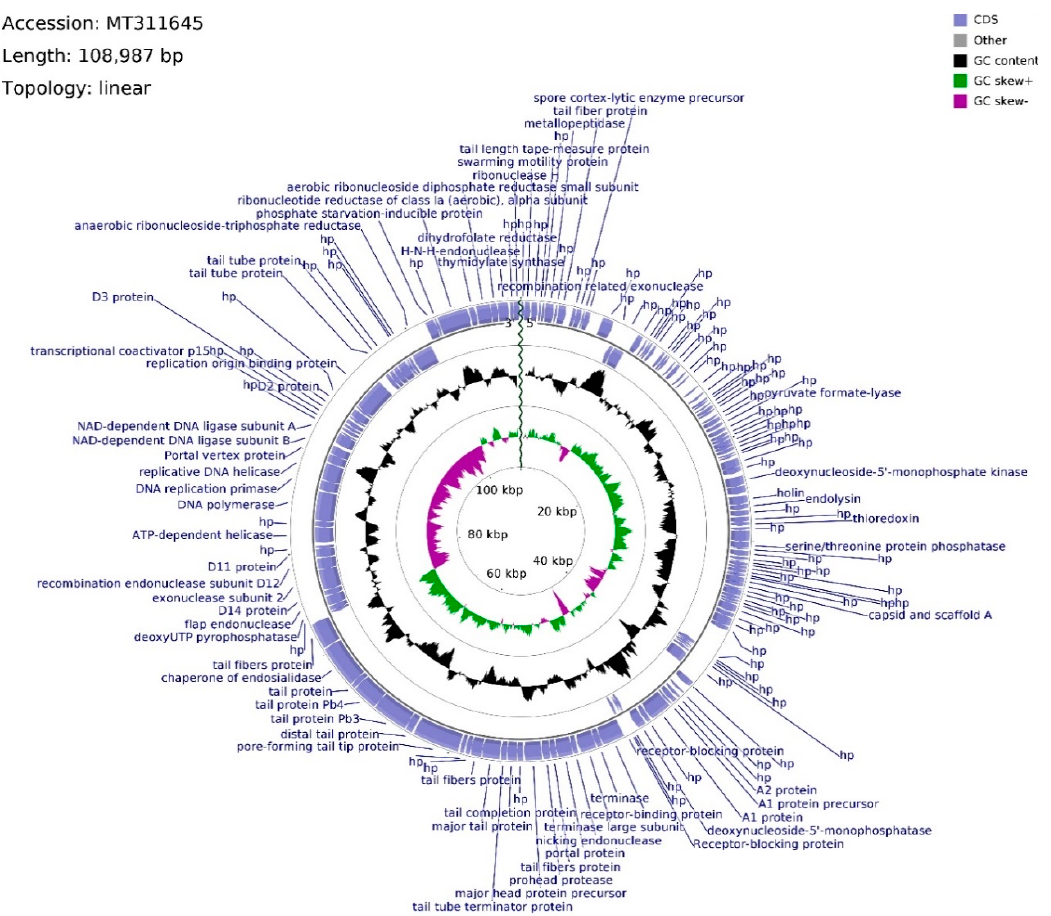
Figure 6. Schematic linear map of phage vB_Sen-E22 genome (ends of the genome are indicated by the wavy line). The inner rings show genome location, GC skew + (green) and − (purple) and GC content (black). The two most external rings show identified open reading frames (blue arrows) and results of genome annotation process.